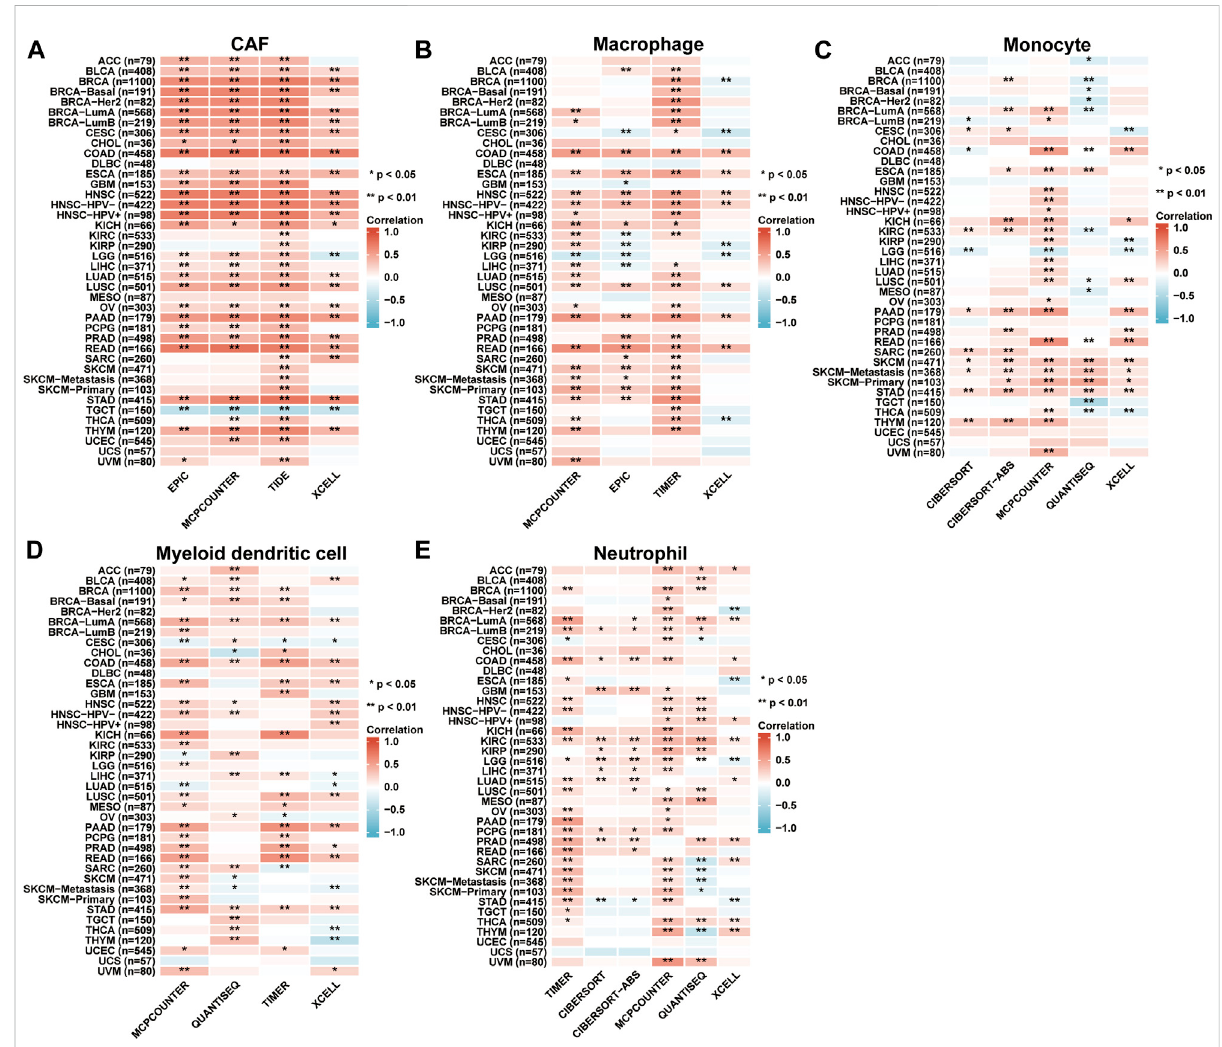
FIGURE 6 Immune in fi ltration analysis based on TIMER2 database. The correlation between the AKAP12 expression and in fi ltration of cancer-associated fi broblasts (A) , macrophages (B) , monocytes (C) , myeloid dendritic cells (D) , and neutrophils (E) . Among all TCGA tumors according to the EPIC, MCPCOUNTER, TIDE, XCELL, TIMER, CIBERSORT, CIBERSORT-ABS, as well as QUANTISEQ algorithms were analyzed. The red color suggests a positive association (0-1),whereas thebluecolor indicatesan inverseassociation(-1-0). Theassociationwith p < 0.05isconsideredstatistically signi fi